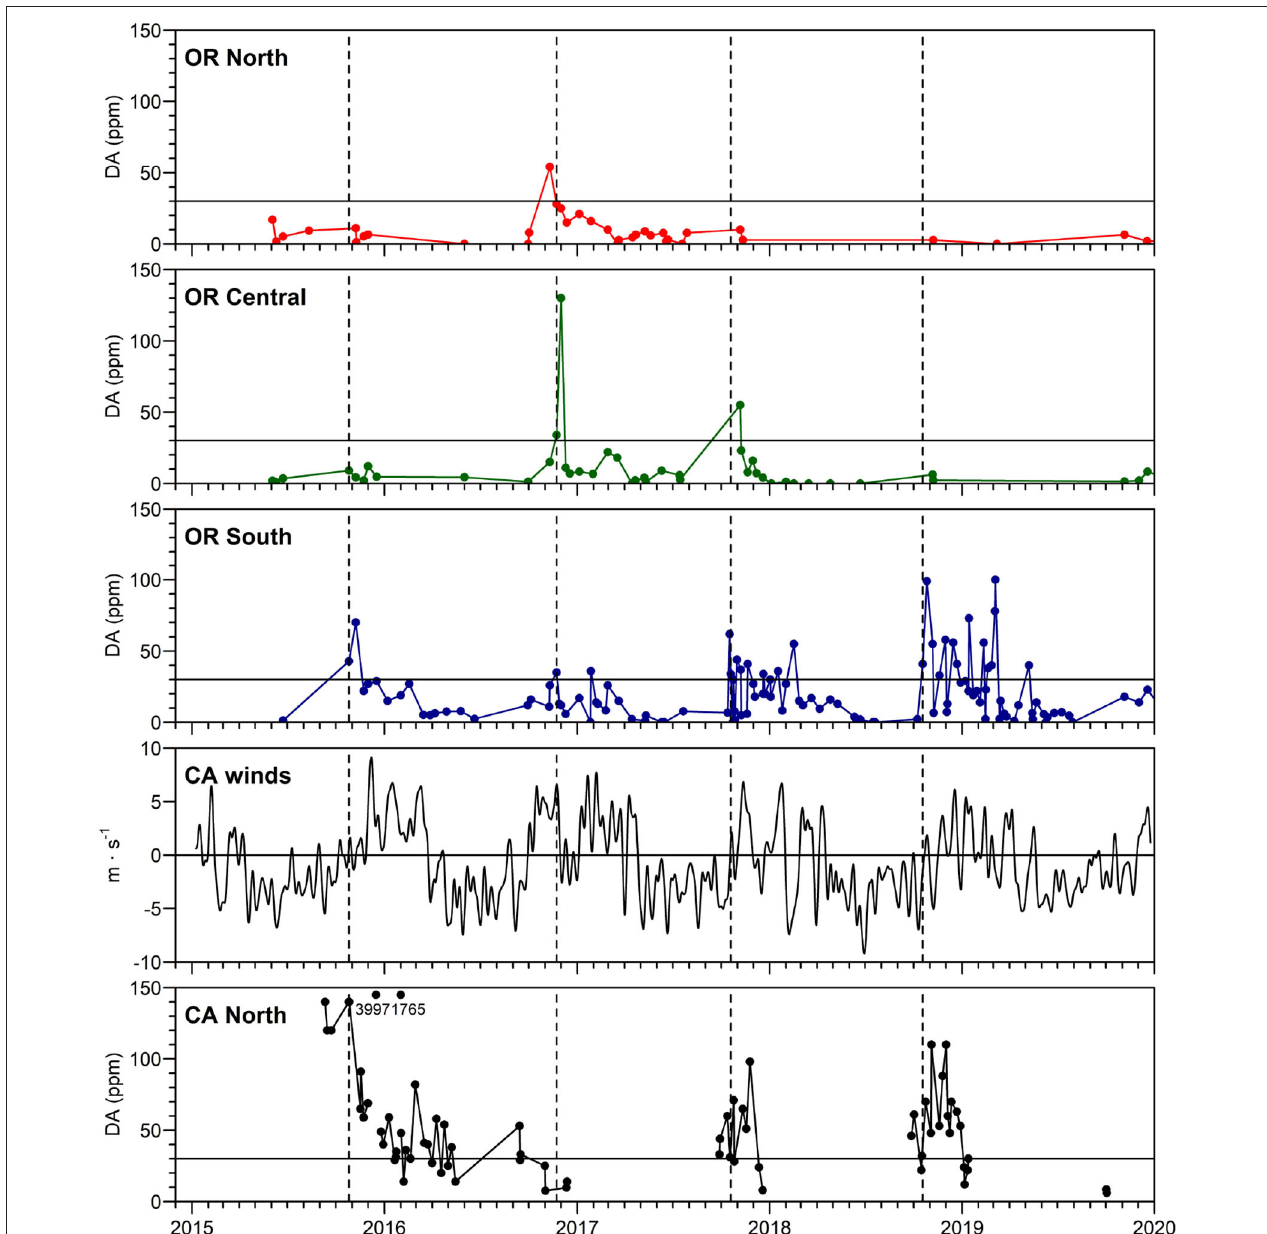
FIGURE 3 | Maximum DA concentrations in Dungeness crab viscera in northern California and southern, central and northern Oregon. The regulatory closure level of 30 ppm DA is shown as a horizontal line on each crab panel. Dotted vertical lines show first appearance of DA above 30 ppm in southern OR crab (which follows DA above 30 ppm in northern CA in all years except 2017). Numbers on the northern CA panel show values of crab DA exceeding the y-axis scale. The north-south component of low pass filtered winds (m s − 1 ), filtered with a 15-day Hanning window, is shown from buoy 46027-6 (location shown in Figure 4 ). Linear regressions with other nearby wind sources were used to fill gaps in the wind time series. Map of regions used for calculation of maximum DA in Dungeness crab, also showing locations of Cape Mendocino (CM) and Cape Blanco (CB). Humboldt County, CA, is found in Figure 4